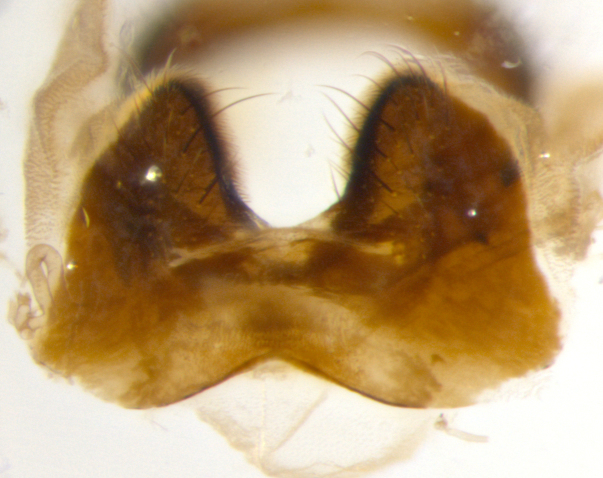
sternite 5, ventral view